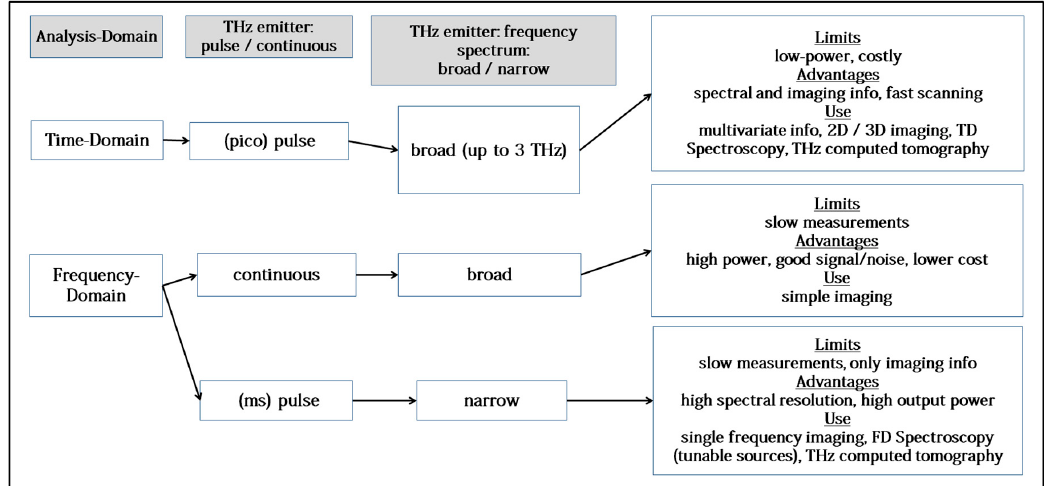
Figure 2. THz imaging and spectroscopy methods used in Cultural Heritage Science.